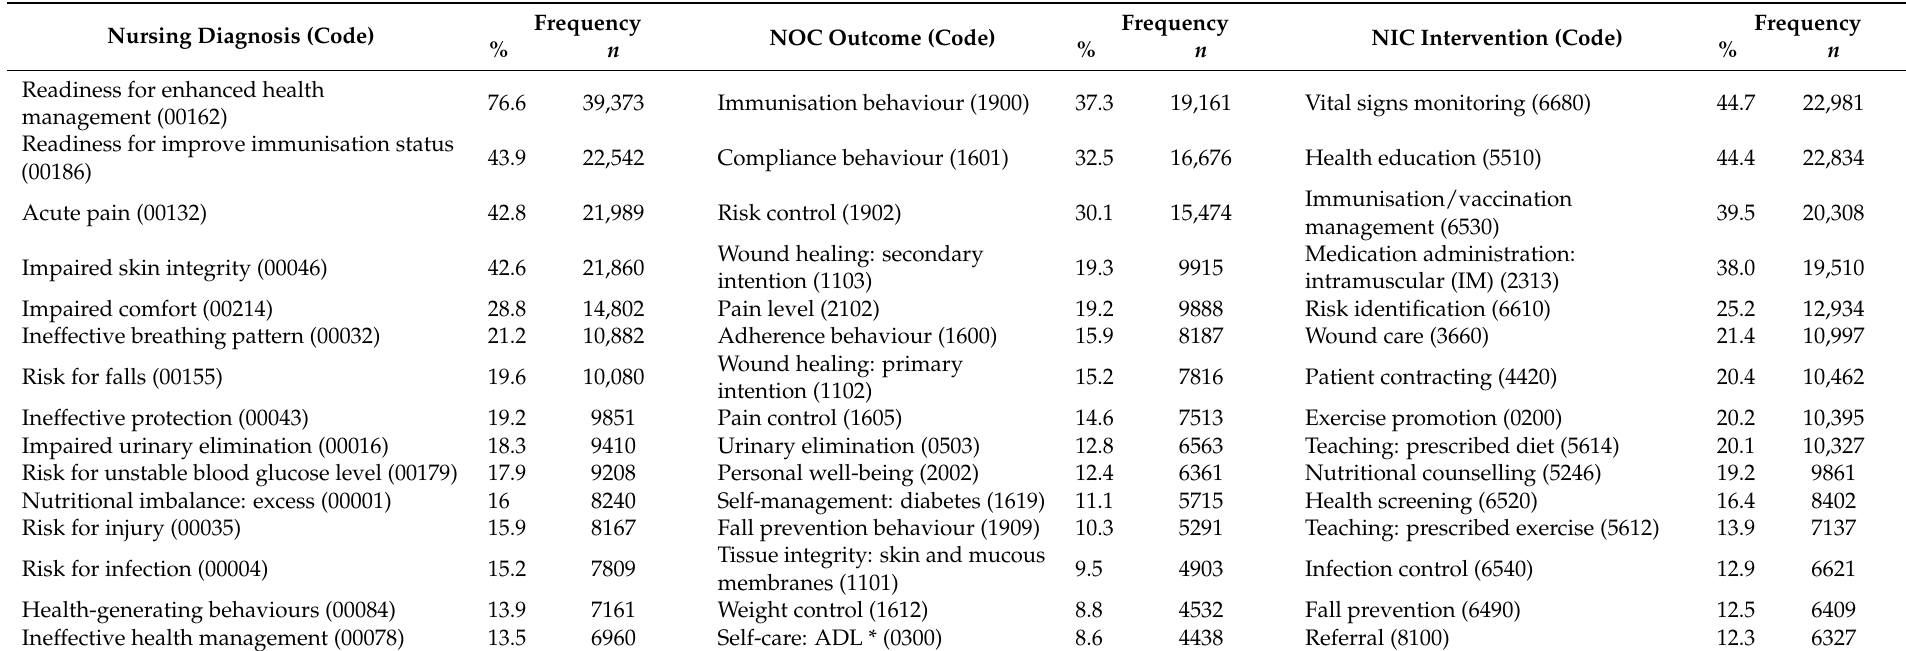
Table 4. Prevalence of NANDA-I nursing diagnoses, NOC outcomes, and NIC